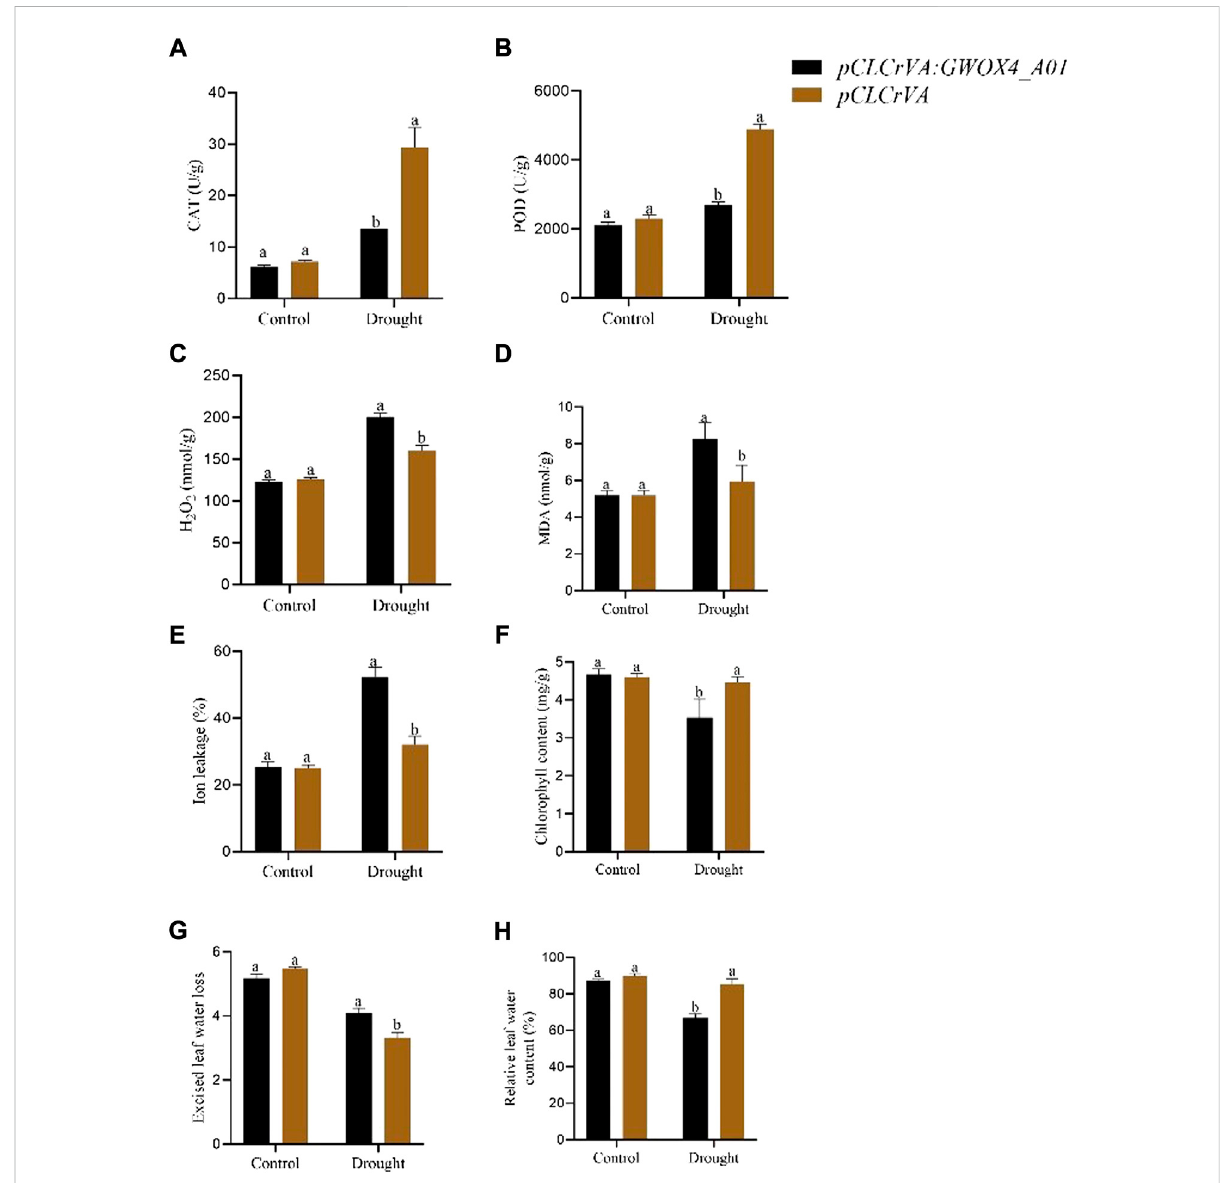
FIGURE 7 Physiological traits and enzyme activity in control and GhWOX4 - A01 silenced plants under control conditions and after 10 days of drought treatments. (A) CAT, (B) POD, (C) H 2 O 2 , (D) MDA, (E) ion leakage percent, (F) chlorophyll content, (G) extracted leaf water lost, and (H) relative leaf water content percent. Each experiment was carried out three times. The error bar represents the standard deviation of the three biological replicates. The signi fi cant difference was indicated by different letters at p <